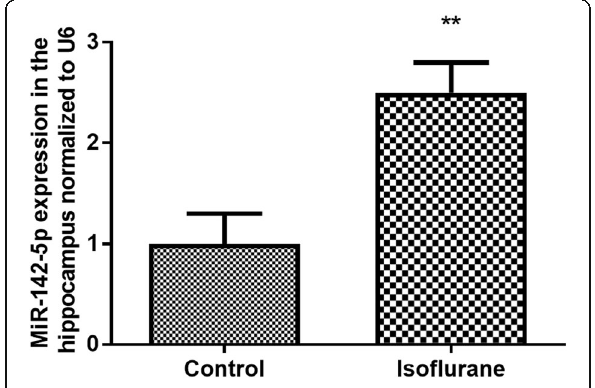
Fig. 2 The expression level of miR-142-5p in rats treated with isoflurane. The expression level of miR-142-5p was increased significantly in the hippocampus of isoflurane-treated rats compared with the control group. ** P <